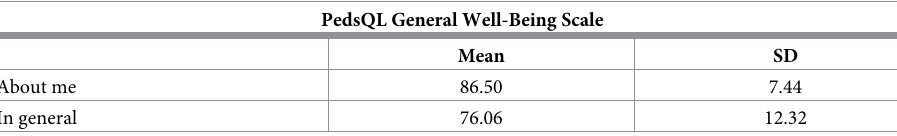
Table 4. Scale descriptives for PedsQL TM 4.0 Generic Core